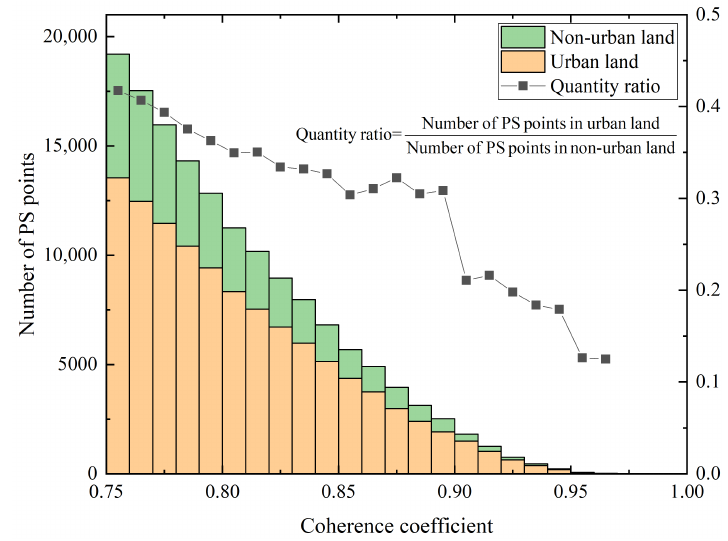
Figure 11. The PS point distribution statistics in the study area.